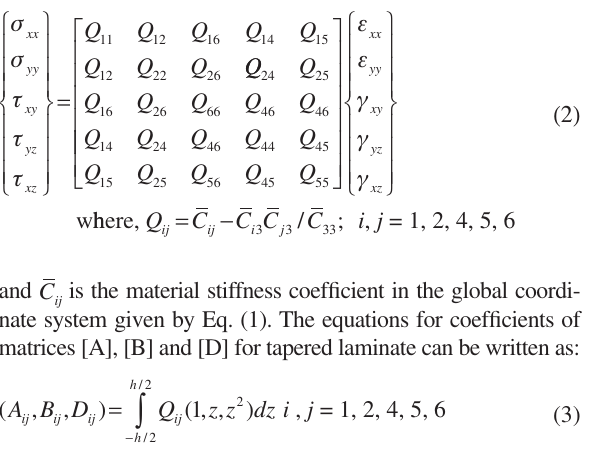
Figure 1 Different longitudinal cross-sections of curved plate. the tapered and uniform-thickness sections as shown in Figure